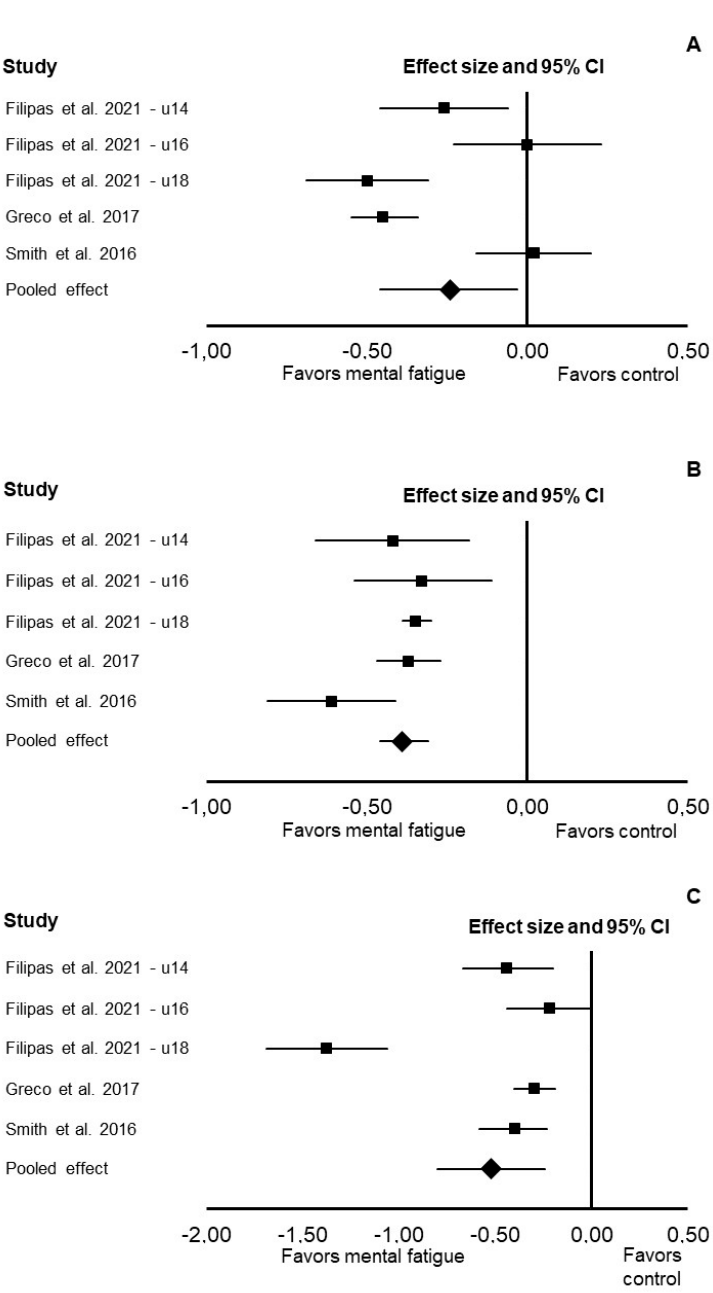
Figure 3. Forest plot presenting the results of the random-effects meta-analysis comparing the effects of control vs. mental fatigue on the original time needed to complete the test ( A ), penalty time ( B ), and performance time ( C ) in the Loughborough soccer passing test. Data are reported as Cohen’s d (effect size) and 95% confidence interval (CI). The diamond at the bottom presents the overall effect. The plotted squares denote effect sizes, and the whiskers denote their 95% CIs.